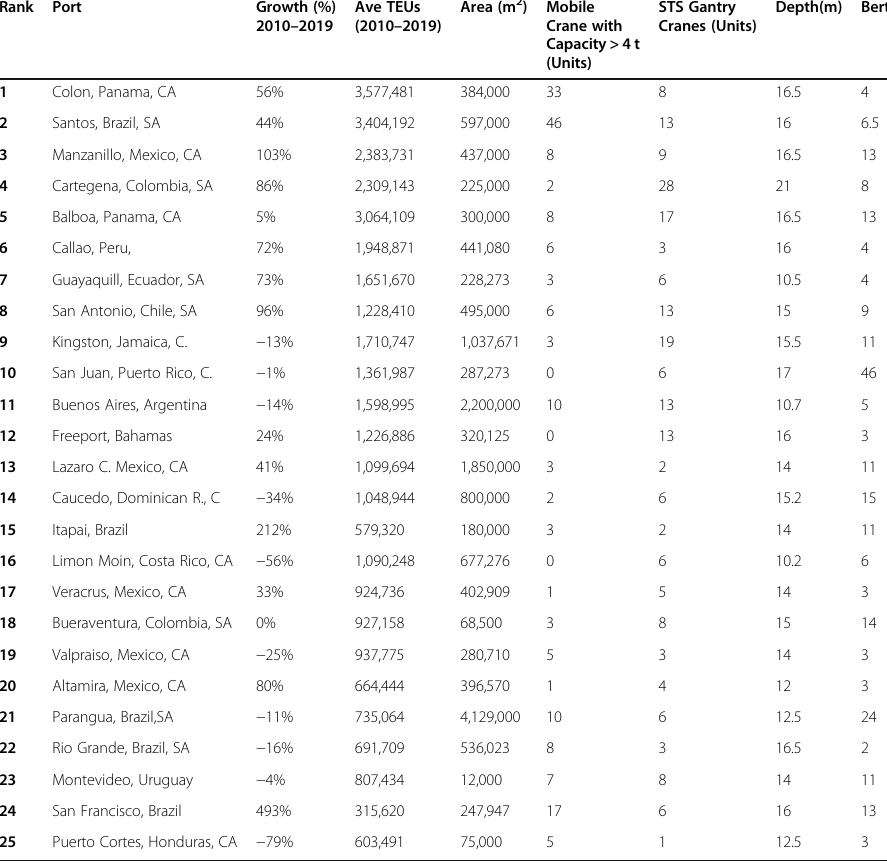
Table 5 Characteristics of 25 LAC Ports